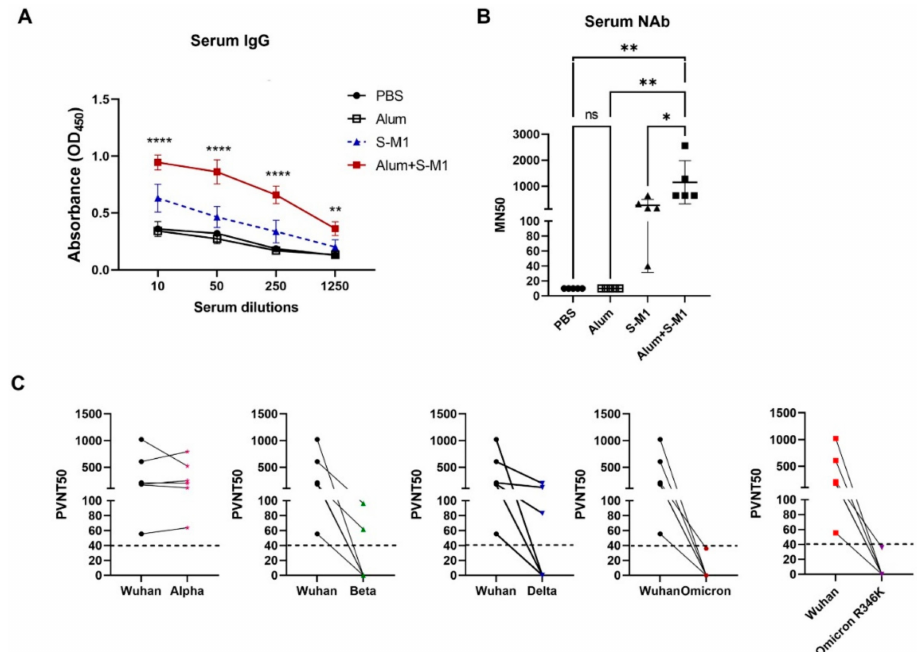
Figure 4. Characterization of neutralizing antibodies in vaccinated BALB/c mice. ( A ) S proteins coated on ELISA plates were incubated with two-fold serial diluted sera from individual mice. Serum IgG was detected with anti-mouse IgG antibodies and visualized by addition of HRP substrate. IgG titers were compared and represented the statistical differences between S-M1 and Alum+S- M1 groups. ( B ) Vero E6 cells seeded in 96-well plates were incubated with live SARS-CoV-2 virus premixed with sera from individual mice. SARS-CoV-2 infection was detected with rabbit α -SARS- CoV-2 N antibodies and visualized by addition of HRP substrate. ( C ) HEK293T-hACE2-TMPRSS2 cells were incubated with S-pseudotyped reporter lentiviruses premixed with increasing dilutions of sera from individual mice that had received alum-S-M1 VLPs. Neutralization was quantified by measuring luciferase activity. Error bars represent means ± sem. ns, no statistical difference; * p < 0.05, ** p < 0.01, **** p <